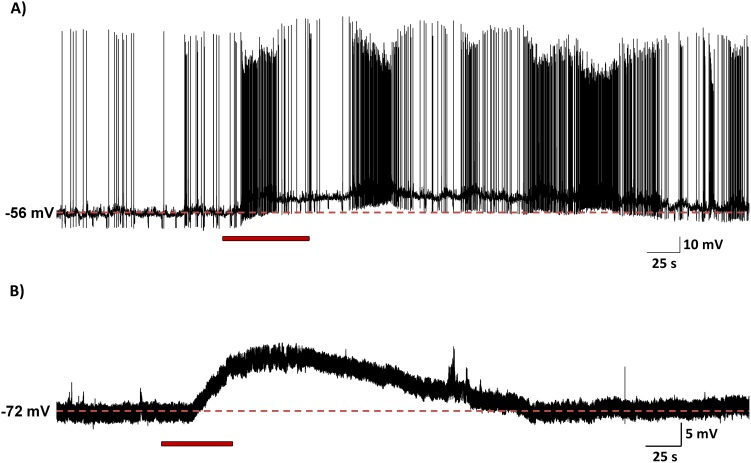
Hydrogen sulfide depolarizes SFO neurons.Current clamp recordings from 2 SFO neurons demonstrating depolarizing effects of 1 mM NaHS (red bars indicate time of application). There was no difference in the depolarizing response observed in neurons that (A) fired spontaneously or (B) cells that were quiescent. In both cases there is a rapid-onset depolarization, followed by a recovery to baseline after return to vehicle aCSF.